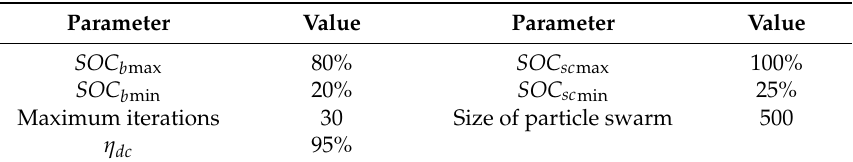
Table 2. Important input parameters.